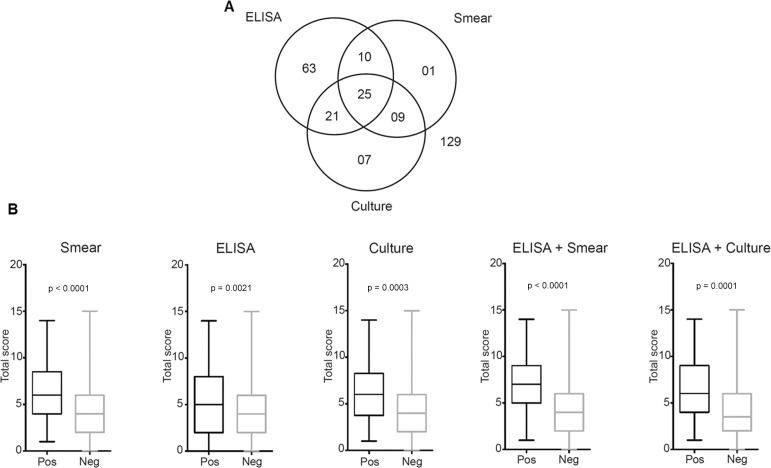
: canine visceral leishmaniasis (CVL) diagnostic tests and clinical signs. ELISA, smear, and culture tests for CVL were performed for all dogs brought to a reference veterinary hospital in the endemic area (A). Total clinical scores (range, 0-19) were higher in dogs with positive results on ELISA, culture, and smear tests and for the combinations of ELISA + culture or ELISA + smear tests (B). Data were compared using the Mann-Whitney test (B).